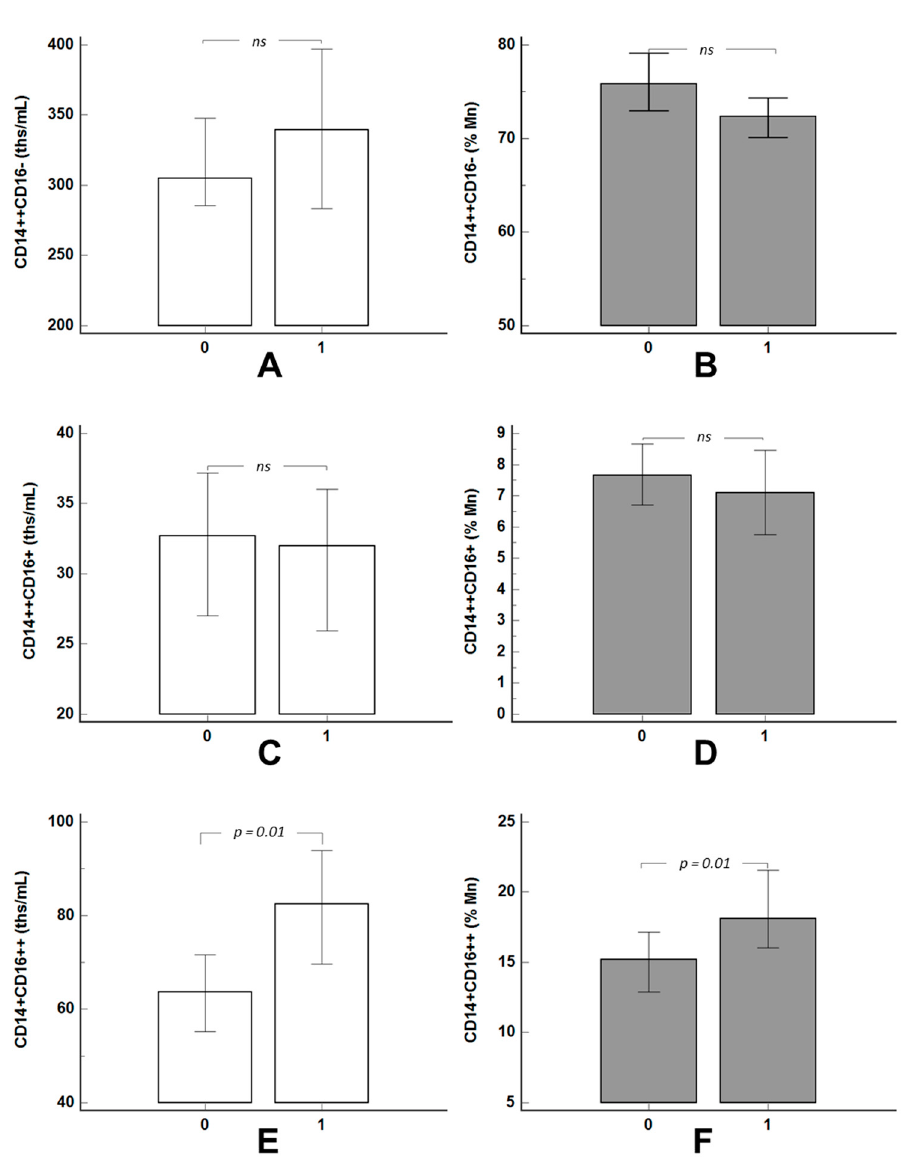
Figure 1. Absolute ( A , C , E ) and relative ( B , D , F ) content of the monocyte subsets in the groups of patients with (“1”) and without (“0”) hyperlipoproteinemia(a). Data are presented as a median and a 95% confidential interval for the median. Mn = monocyte content. “ns”—not significant ( p > 0.05). A weak positive correlation was found between the Lp(a) concentration and the content of non-classical CD14+CD16++ monocytes in absolute and relative values (r = 0.20, p = 0.01 and r = 0.19, p = 0.02, respectively) in the total cohort of patients. According to the ROC analysis, the content of non-classical CD14+CD16++ monocytes of more than 67.6 10 3 /mL and 21.3% of monocytes was associated with hyperLp(a) with a sensitivity of 67% and 40%, respectively, and a specificity of 58% and 82%, respectively. No significant associations were found for the other monocyte subsets. A slight negative correlation was found between age and the absolute number of classical CD14++CD16 − monocytes (r = − 0.301, p = 0.0002). The association of the relative content of classical (r = − 0.26, p = 0.0013), intermediate (r = 0.247, p = 0.002) and non- classical monocytes (r = 0.169, p = 0.04) with age was also observed. According to the multivariate regression analysis, the association of the relative content of non-classical CD14+CD16++ monocytes with the Lp(a) concentration retained a statistical significance when adjusted for gender and age (r = 0.176, p =